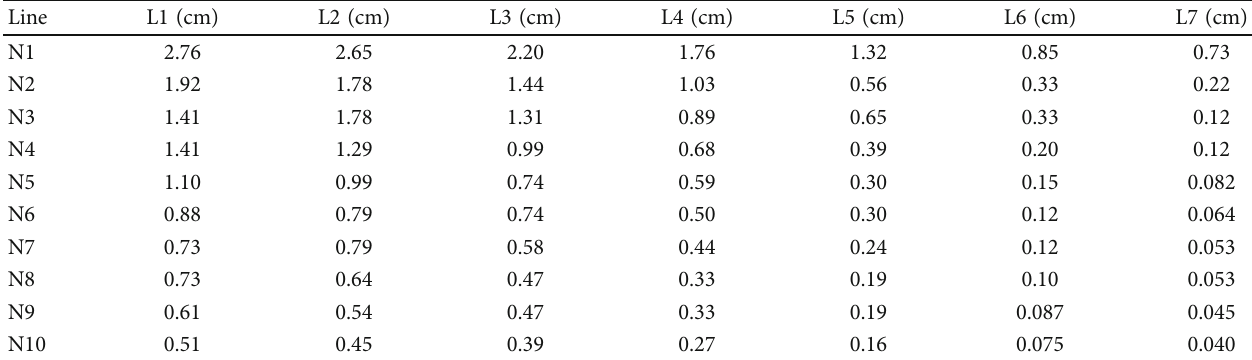
Table 4: The radial displacements of each survey